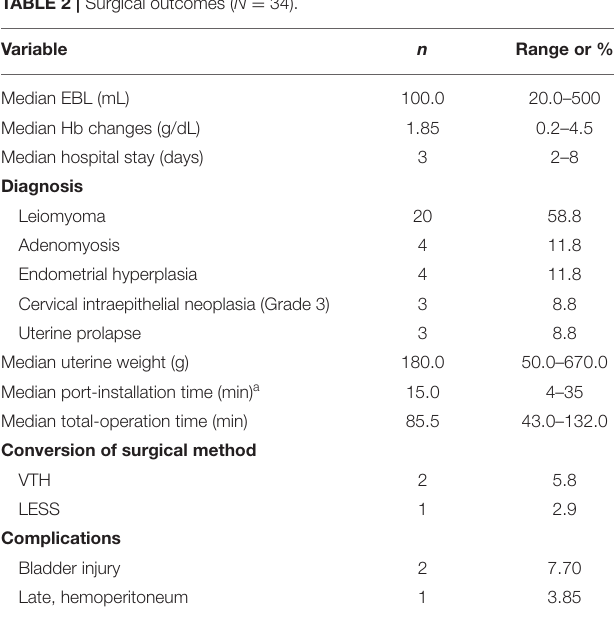
TABLE 2 | Surgical outcomes ( N = 34).